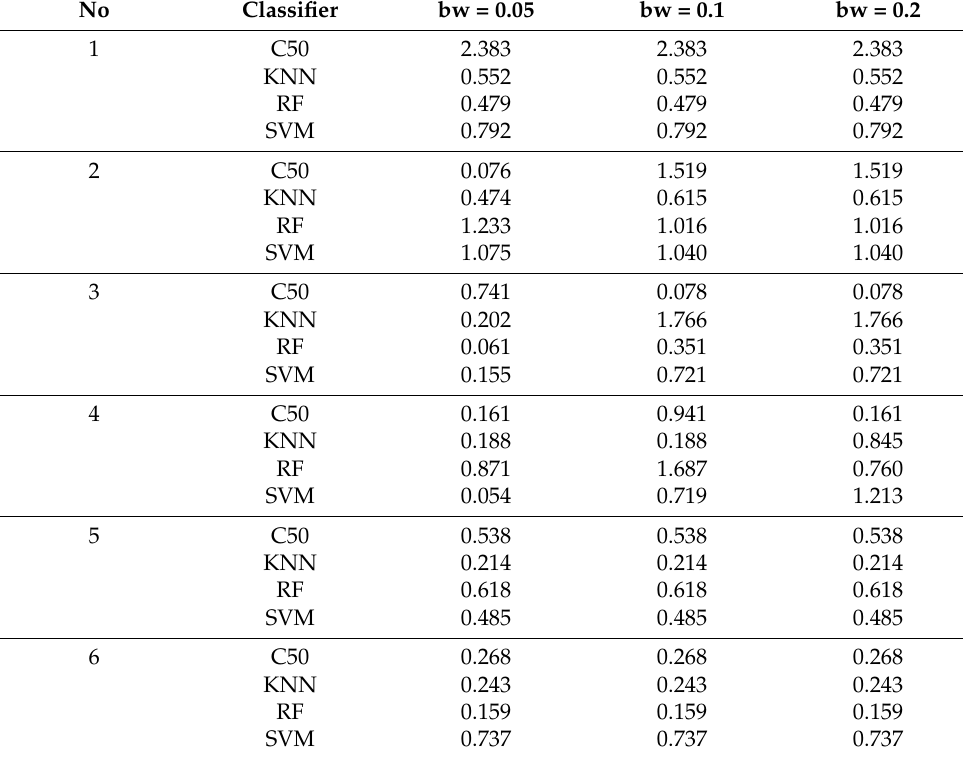
Table A2. MAI of FWS according to bin width (K =